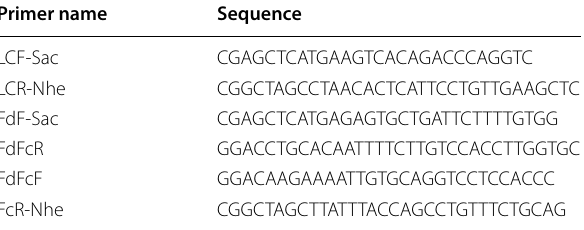
Table 2 Primers used in plasmids